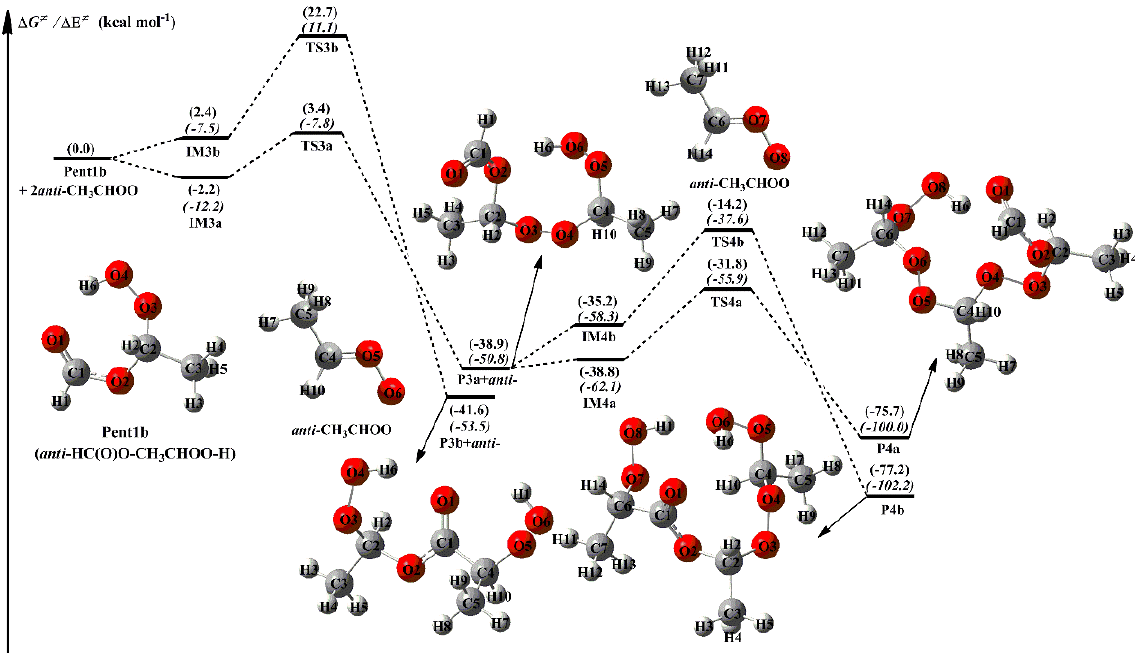
Figure 3. PES ( (cid:49)G and (cid:49)E ) for the 2 anti -CH 3 CHOO + Pent1b reaction at the M06-2X/ma-TZVP//M06-2X/6-311 + G(2df,2p) level of theory.